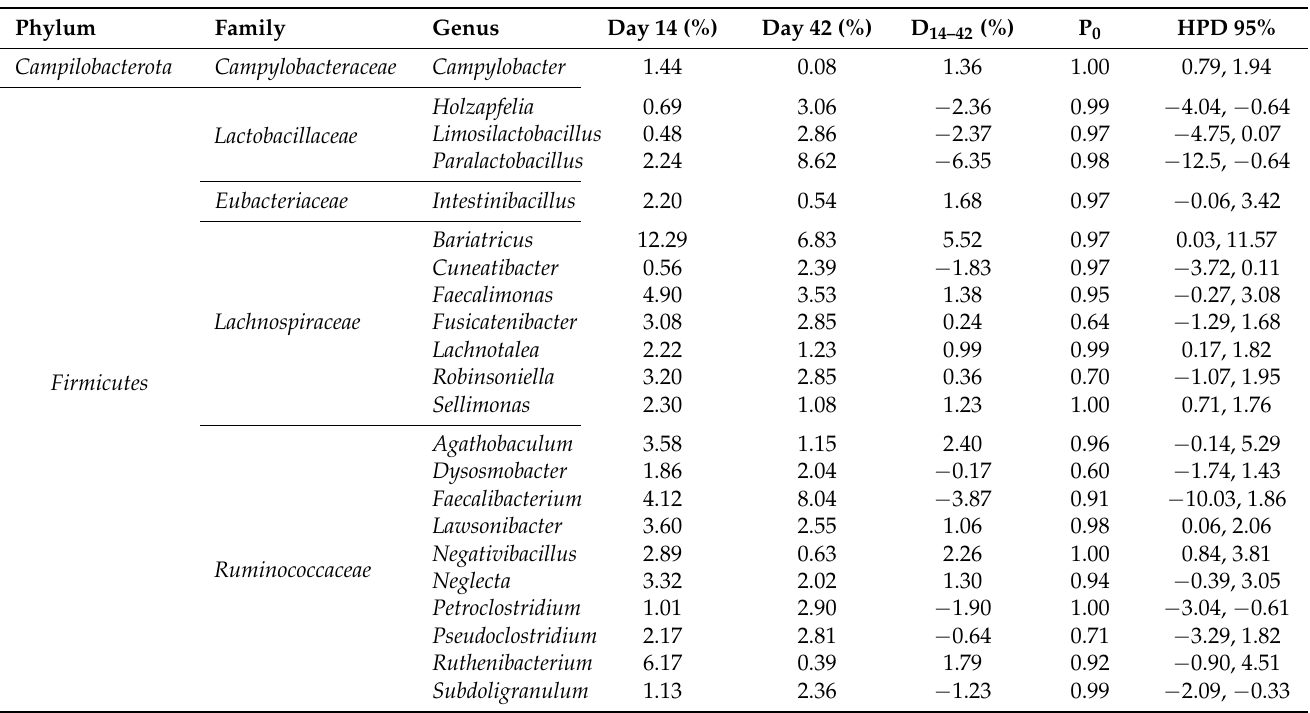
Table 3. Taxonomic profiles at genus level and Bayesian analyses of the relative abundance comprising more than 2% of the total bacterial sequences in at least one of the different ages of rearing (14- and 42-day-old